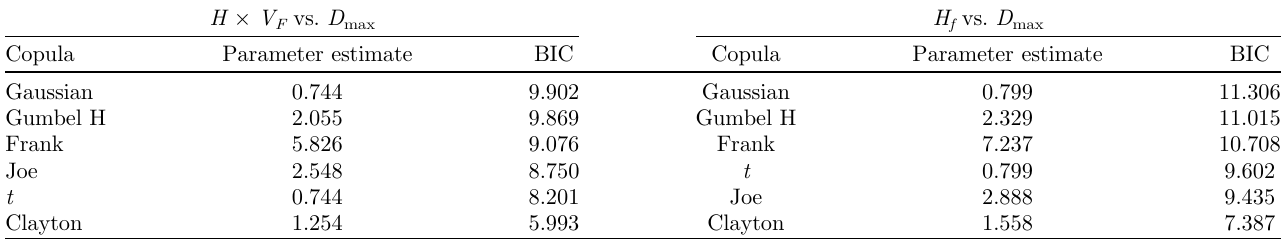
Table 2. Parameters estimated by Maximum Log-Likelihood (MLL) and BIC values for the copula between the pseudo-observations ranks(dam factor) and ranks ( D max ). Left: dam factor = H (cid:1) V F , ^ g = 12378.75; Right: dam factor = H f , ^ g = 1479.85. In both cases the degrees g are estimated by MLL using the tCopula() function of the copula R-package.